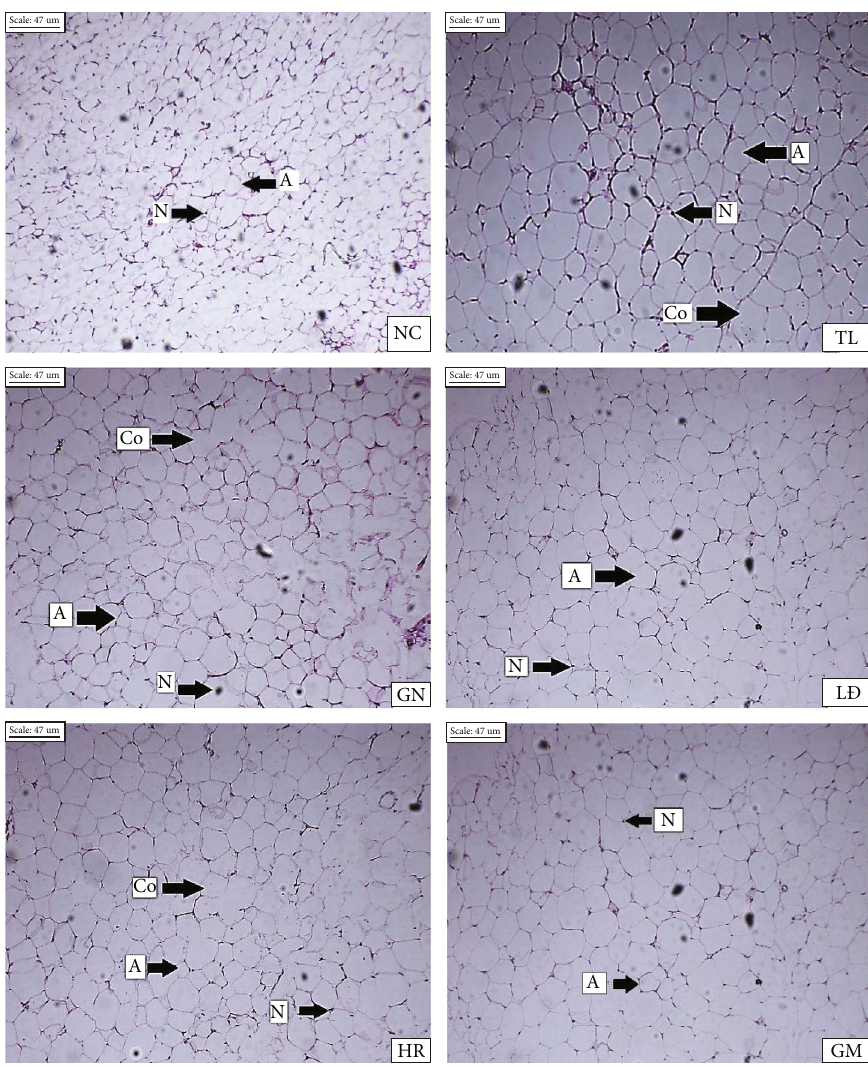
Figure 3: Photomicrographs of white adipose tissue ( × 100) (A: adipocytes; Co: coalescence; N: